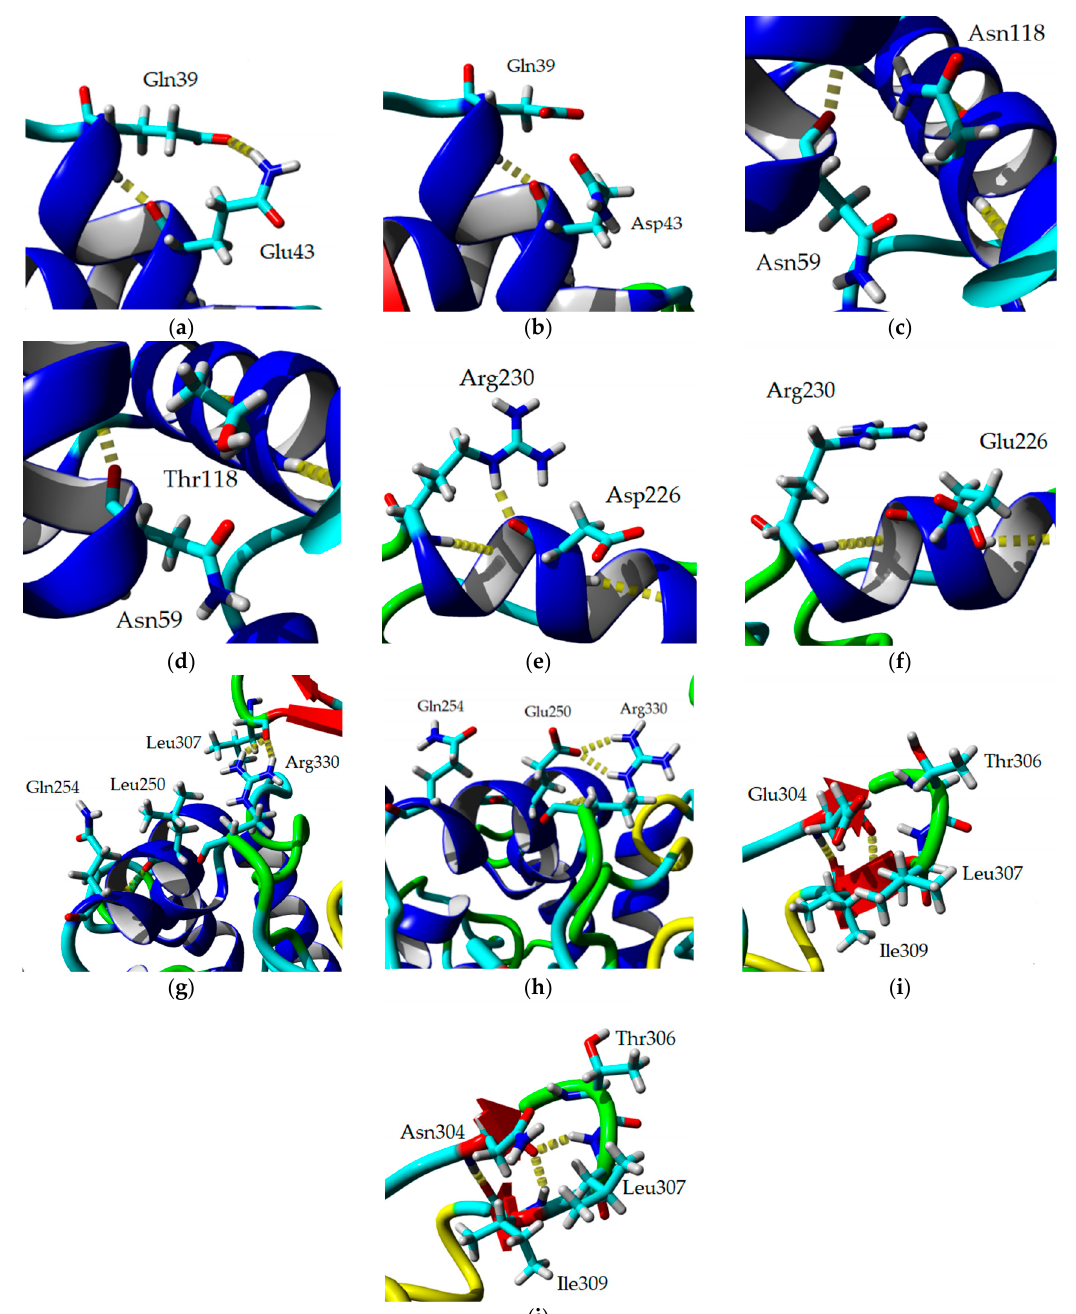
Figure 11. Structure model of 5M mutant and three-dimensional structure of Earth-grown T1 lipase crystal structure with hydrogen bonds and ion interaction. ( a ) Hydrogen bond between residues Gln39 and Glu43 in 5M. ( b ) Hydrogen bond between residues Gln39 and Glu43 in T1. ( c ) Hydrogen bond between residues Asn59 and Asn118 in 5M. ( d ) Hydrogen bond between residues Asn59 and Thr118 in T1. ( e ) Hydrogen bond between residues Asp226 and Arg230 in 5M. ( f ) Hydrogen bond between residues Glu226 and Arg230 in T1. ( g ) Hydrogen bond between residues Leu250, Arg330, and Gln254 in 5M. ( h ) Hydrogen bond and ion interaction between residues Glu250, Arg330, and Gln254 in T1. ( i ) Hydrogen bond between residues Glu304 and Thr306 in 5M. ( j ) Hydrogen bond between residues Glu304 and Thr306 in T1.